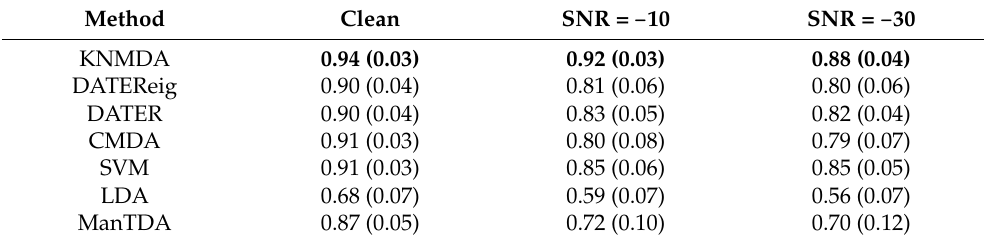
Table 8. Classification of tensors extracted from ECG recordings, with different signal-to-noise ratios (mean AUC and standard deviation). The bold values represent the best performance for each column.